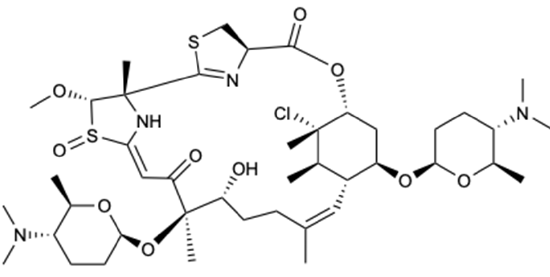
Figure 14. Structure of forazoline A ( 49 ).